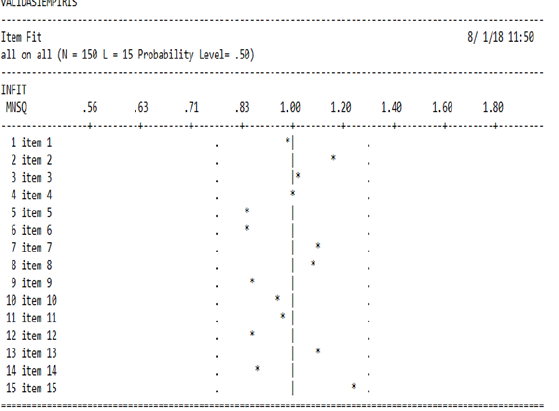
Figure 1. Results Quest analysis of em- pirical